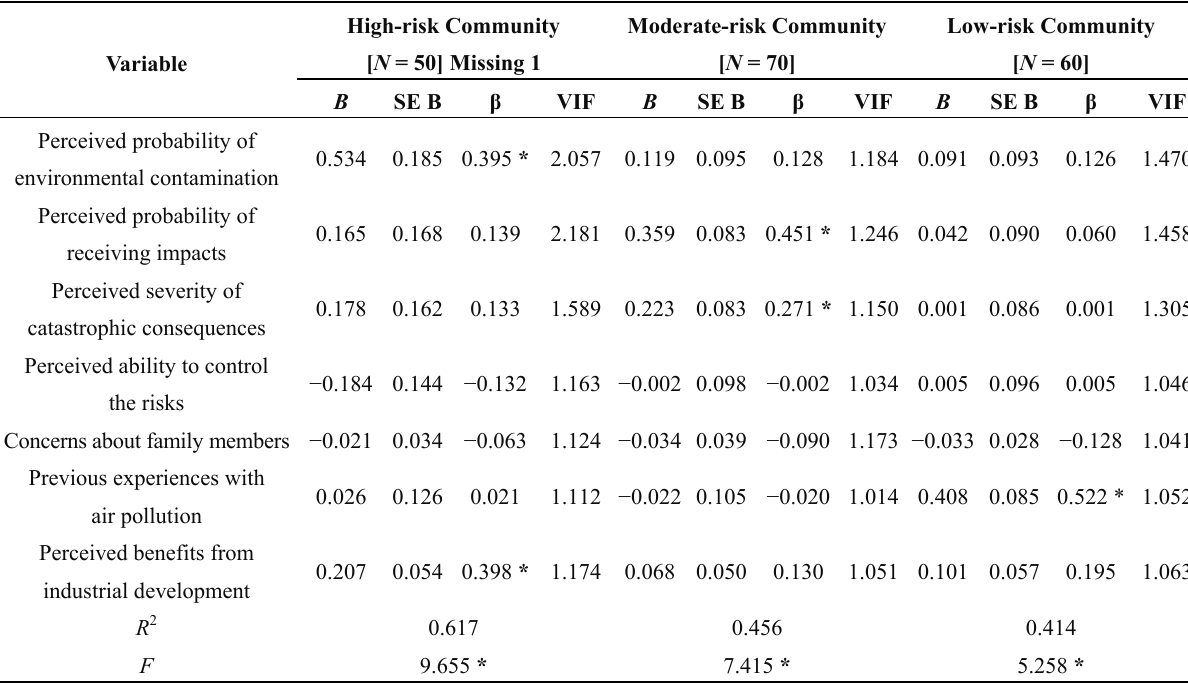
Table 8. Summary of regression analysis for variables predicting environmental risk